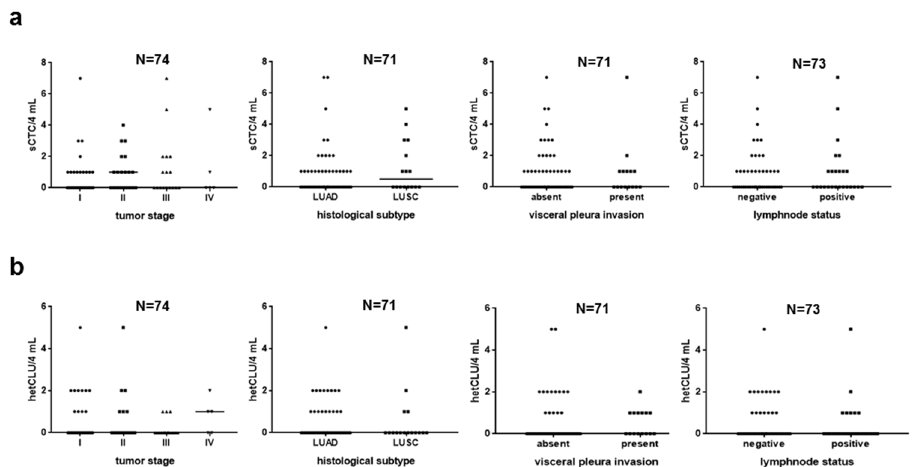
Figure 2. The number of single CTCs (sCTC) and heterotypic CTC clusters (hetCLU) is not associated with the clinicopathological features of stage I–IVA non-small cell lung cancers. Dot plots represent the distribution of ( a ) sCTC or ( b ) hetCLU count (median number, line) in 4 mL of peripheral blood according to the tumor stage, the histological subtype (LUAD, lung adenocarcinoma; LUSC, lung squamous cell carcinoma), the visceral pleura invasion and the lymph-node involvement. Differences were not significant ( p -value > 0.05) by Kruskal–Wallis (tumor stage) or Mann–Whitney